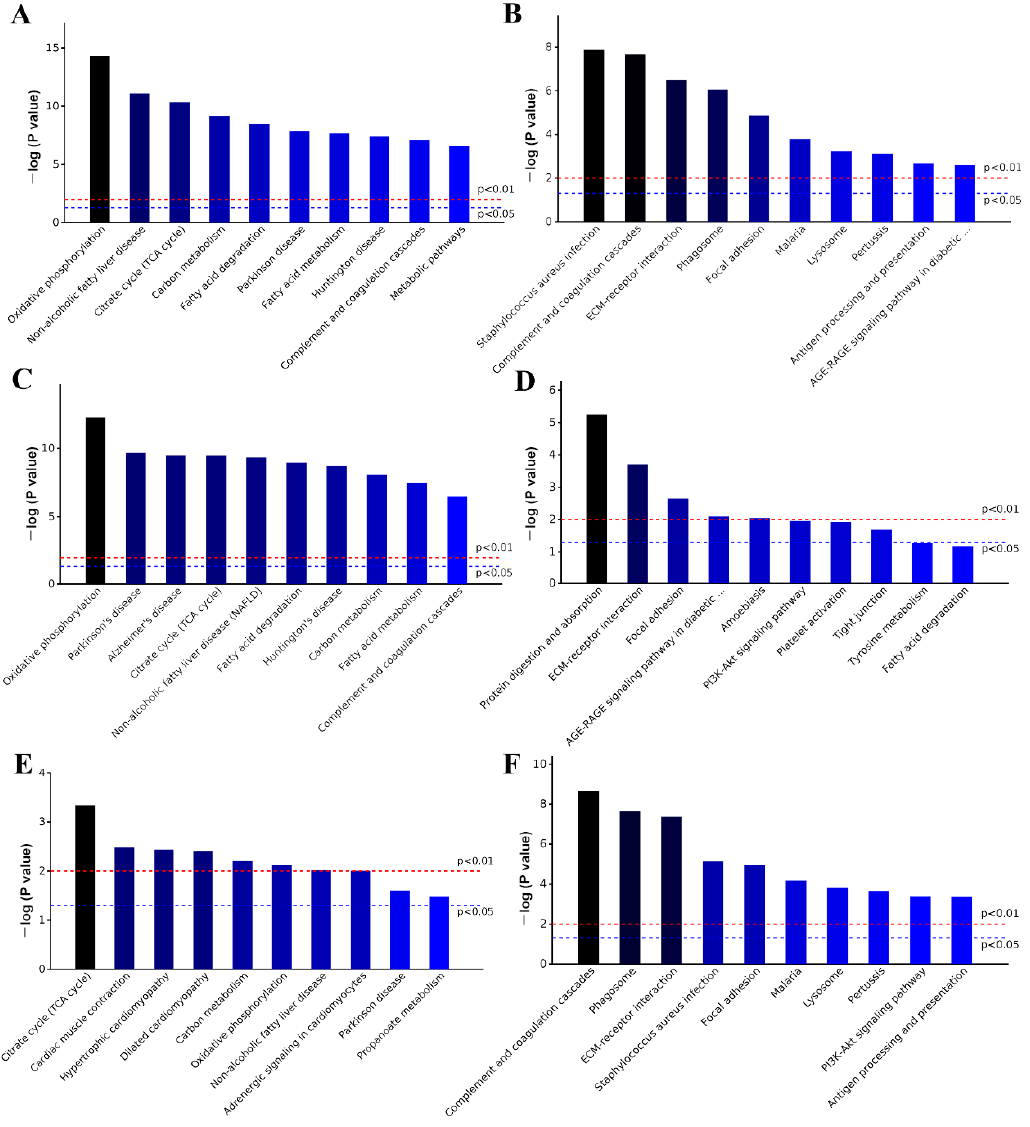
Figure 6. KEGG enrichment analysis of all differentially expressed proteins. KEGG enrichment analyses of the aortic differentially expressed proteins of HFD group versus ND group ( A ). KEGG enrichment analyses of the aortic differentially expressed proteins of HFD + LI group versus HFD group ( B ). KEGG enrichment results of the aortic HFD up- or down-regulated proteins (versus ND) (( C , D ), respectively), and HFD-LI up- or down-regulated proteins (versus HFD) (( E , F ), respectively). Top 10 clusters ( p < 0.05). KEGG, Kyoto Encyclopedia of Genes and Genomes.